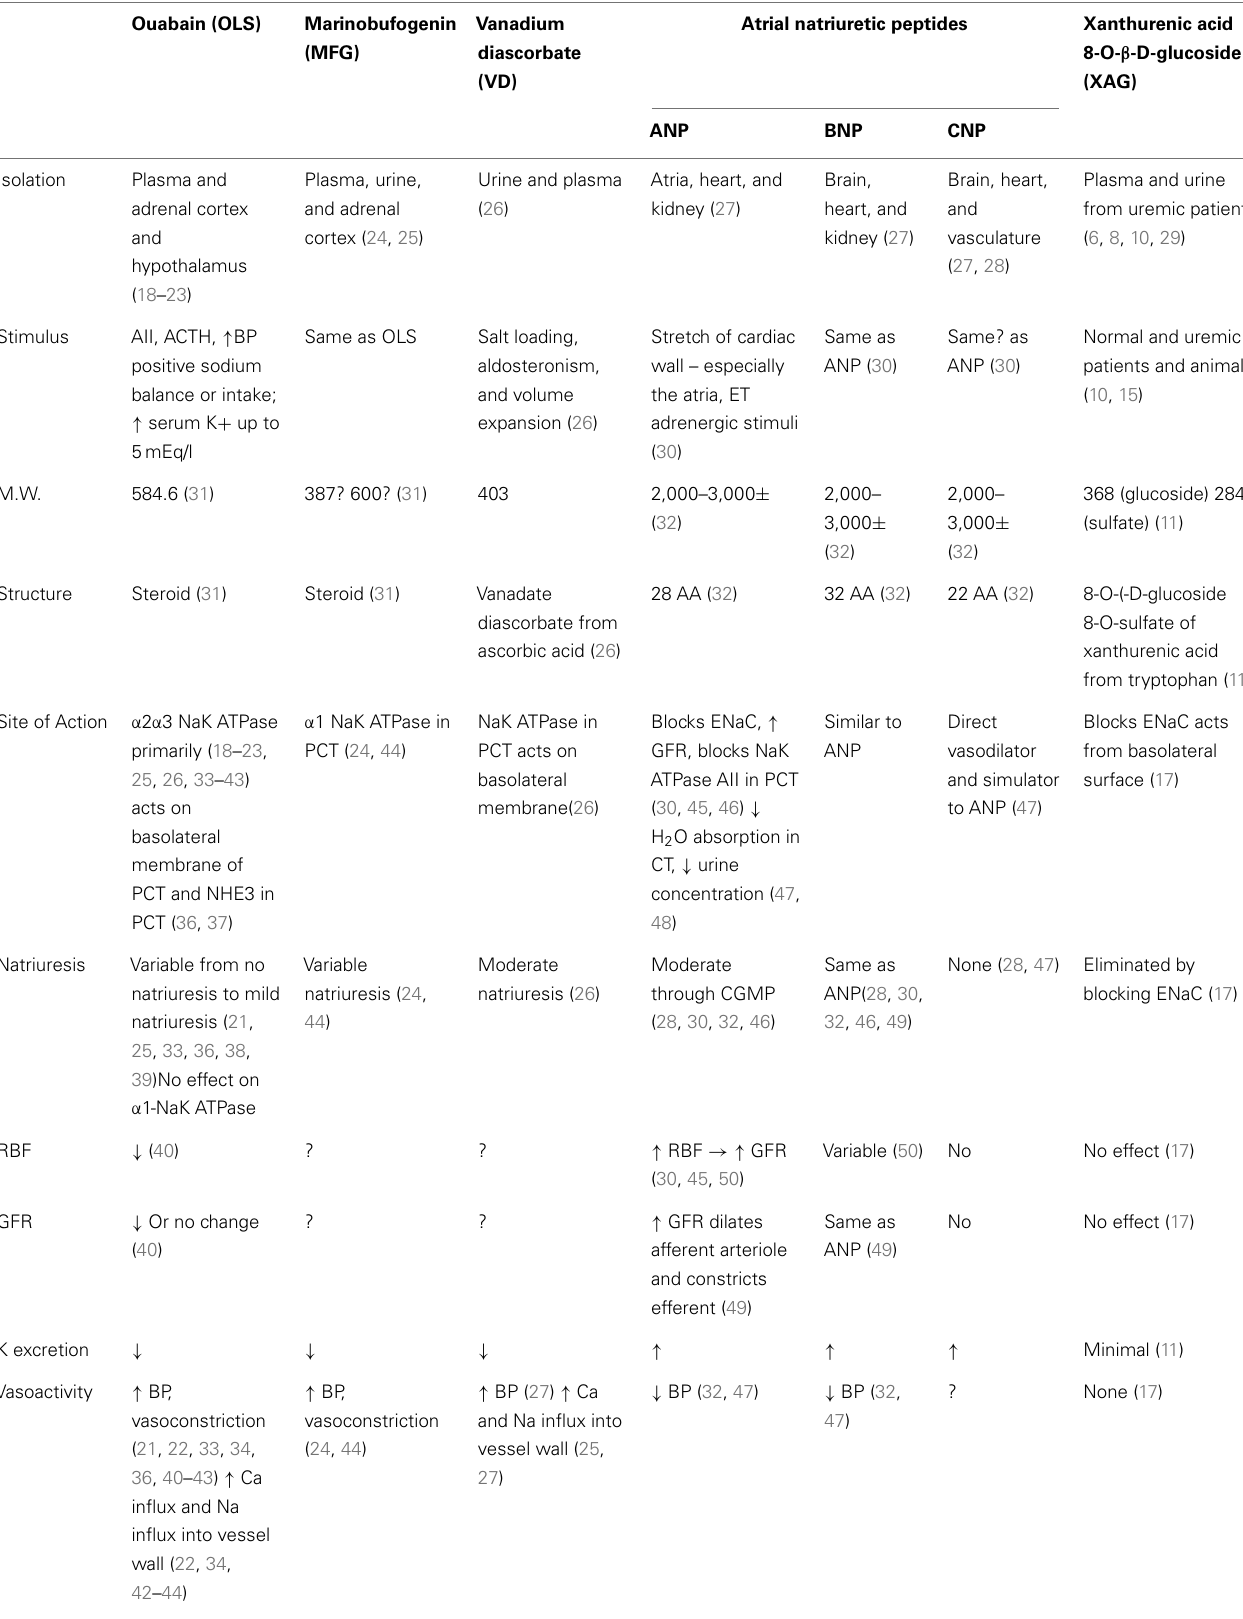
Table 2 |A comparison of several natriuretic substances